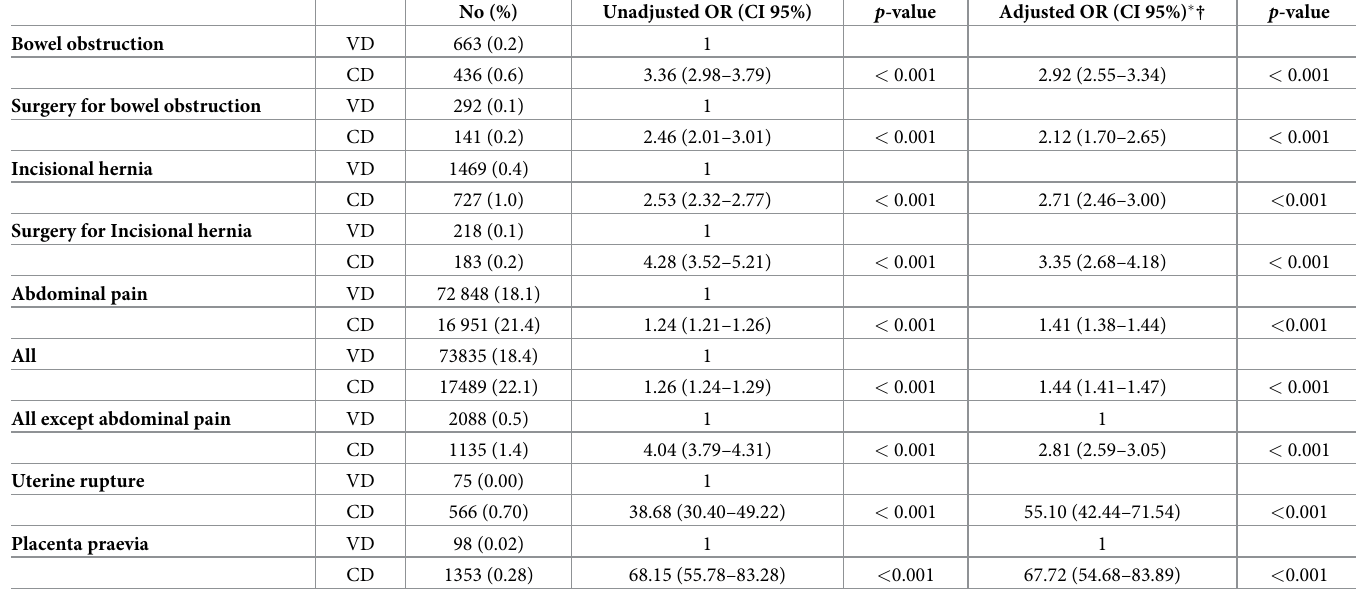
Table 2. a. Odds ratio for surgical complications after delivery. Uni- and multivariable logistic regression analysis. b. Odds ratio for uterine rupture and placenta praevia during pregnancy or delivery. Uni- and multivariable logistic regression